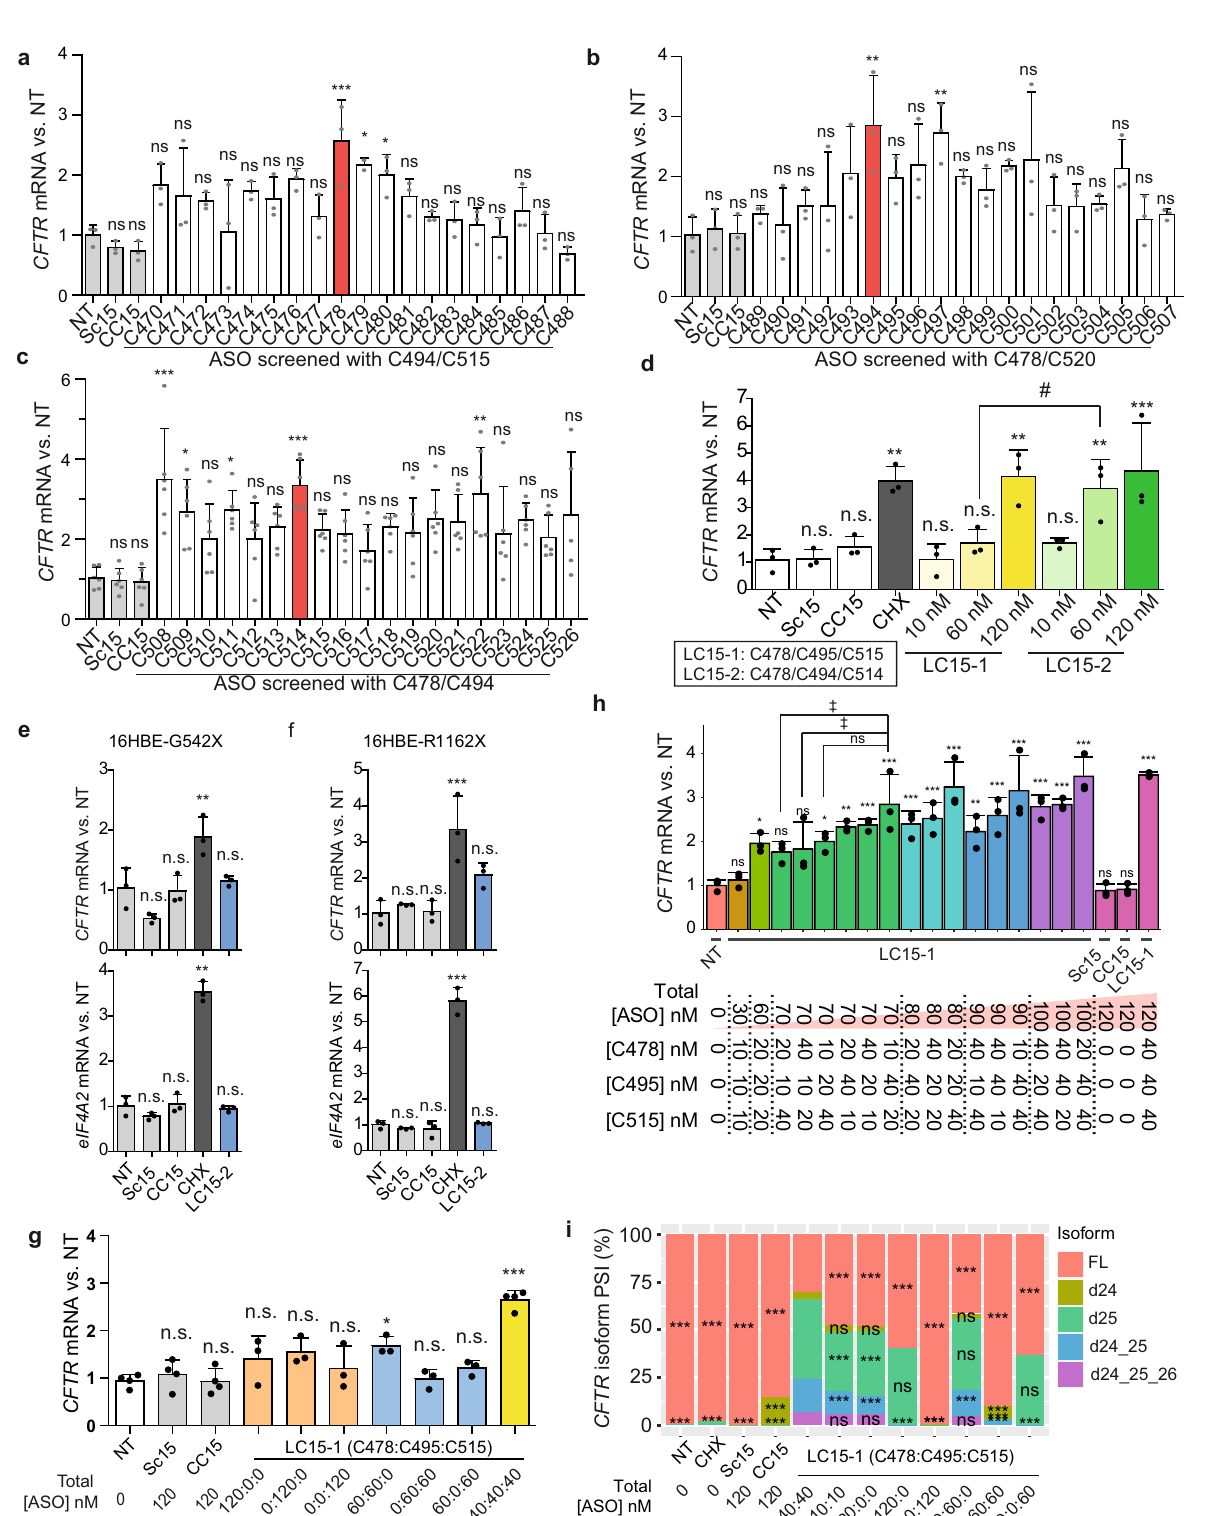
skipping. As disrupted binding of serine-rich (SR) proteins to exonic splicing enhancers (ESEs) by uniformly modi fi ed MOE-PS ASOs can cause exon skipping 34 – 37 , we used ESE fi nder 38 to